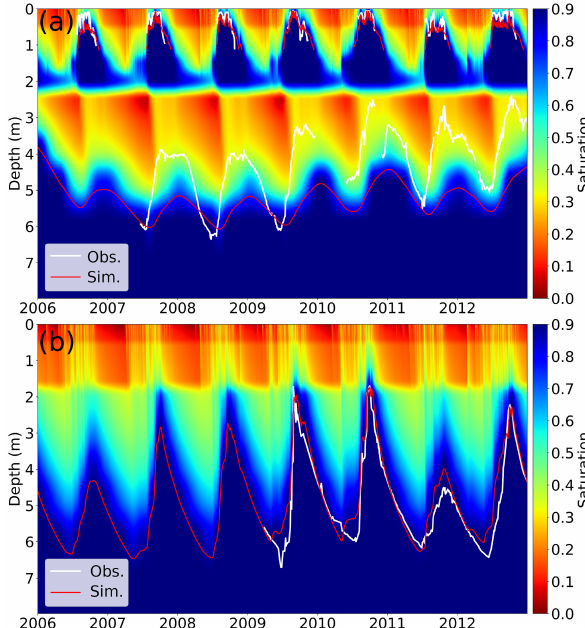
Figure 4. Simulated saturation and observed and simulated water table. (a) In the inland valley (at P1) and for the reference simula- tion (clayey H3 layer); (b) in the upstream area (at P2) and for the saprolite simulation (sandy H3